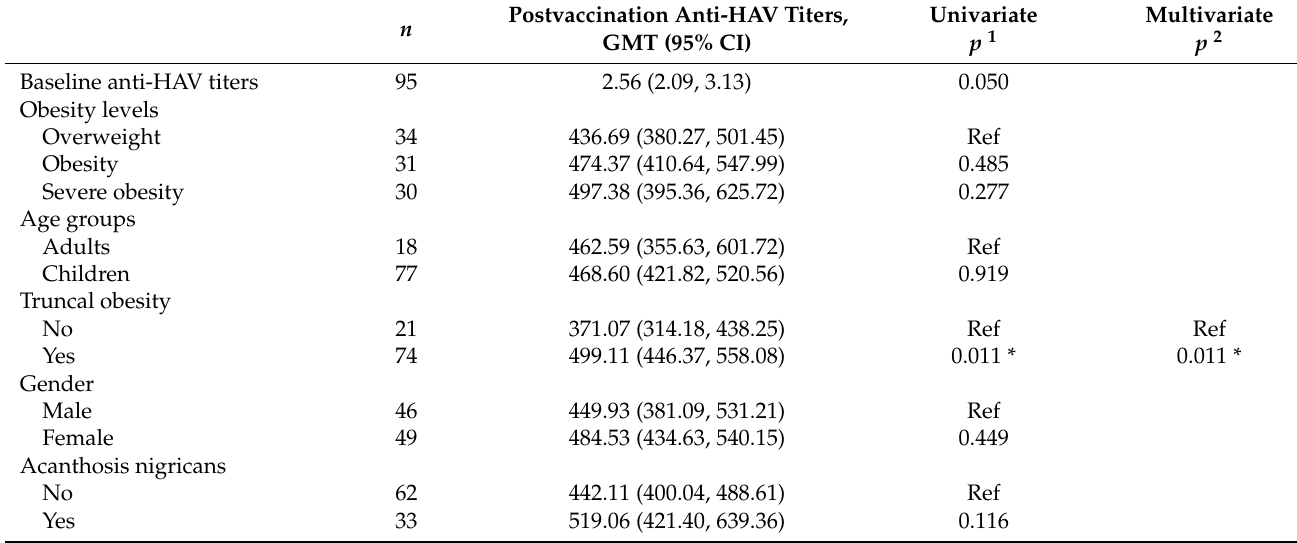
Table 3. Association between baseline characteristics and postvaccination anti-HAV titers in obese group.